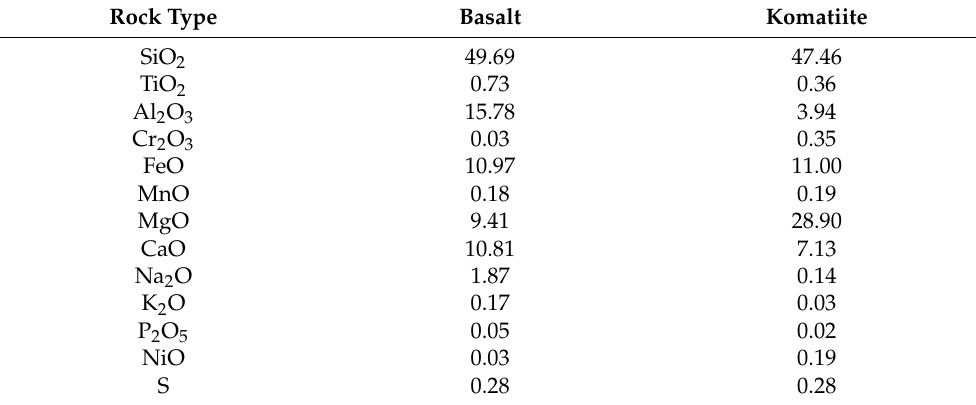
Table 1. Chemical compositions of rocks (wt.%) used in this study.